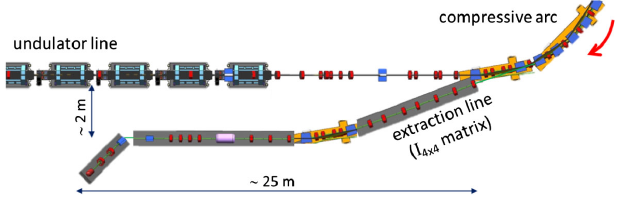
FIG. 6. Top view of the off-line diagnostic line as a branch of the CA. The beam moves from right to